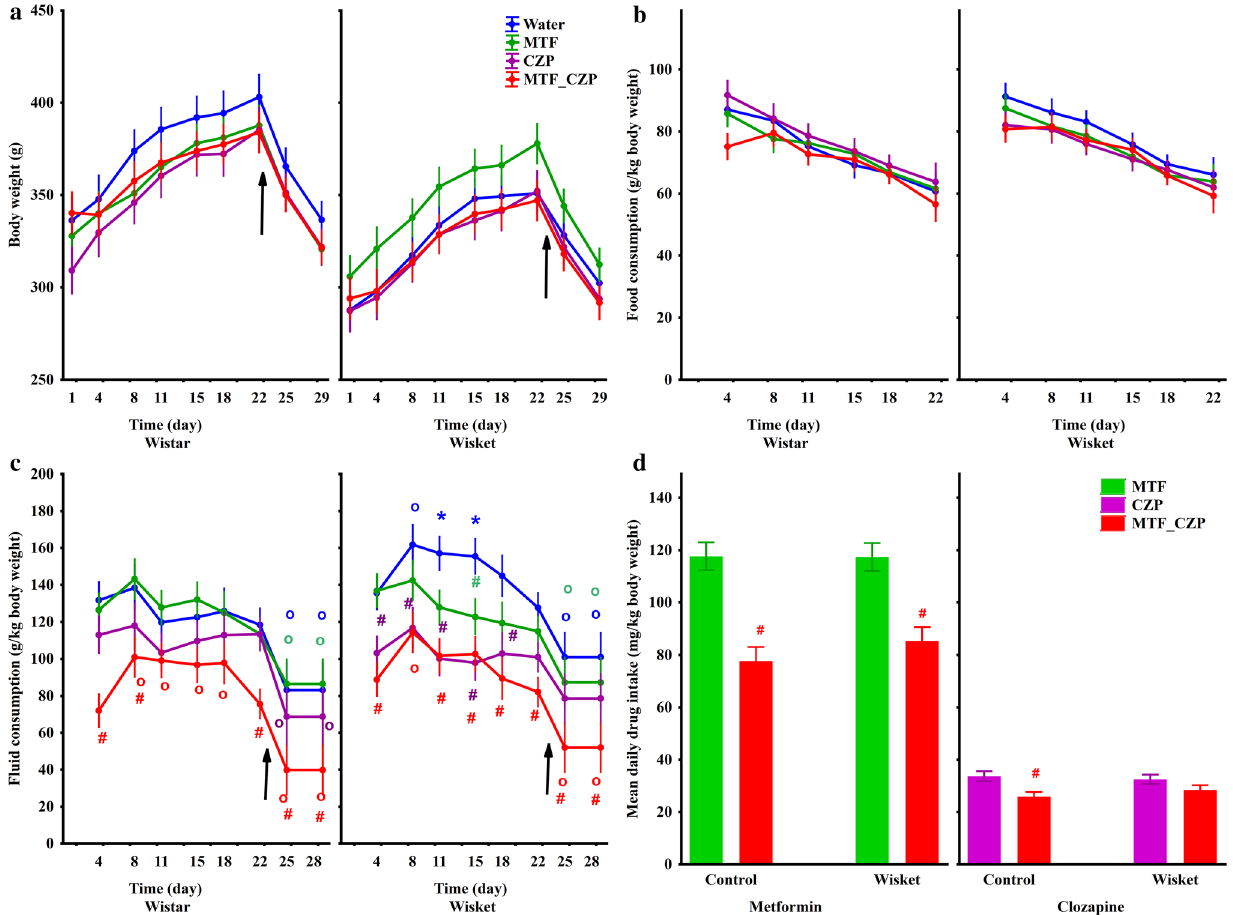
Figure 2. Time-course curves of body weight ( a ), food consumption ( b ), and fluid consumption ( c ) according to group. The symbols indicate significant differences between the Wistar and Wisket groups (*) compared with the water-drinking animals (#), the CZP-alone group (x), and the Day 1 values (o). The arrows indicate the starting of the food restriction. Differences in MTF (left side) and CZP (right side) uptake ( d ) observed between the single and combined treatments during the whole investigation period. The symbol # indicates significant differences between the single and combined treatment